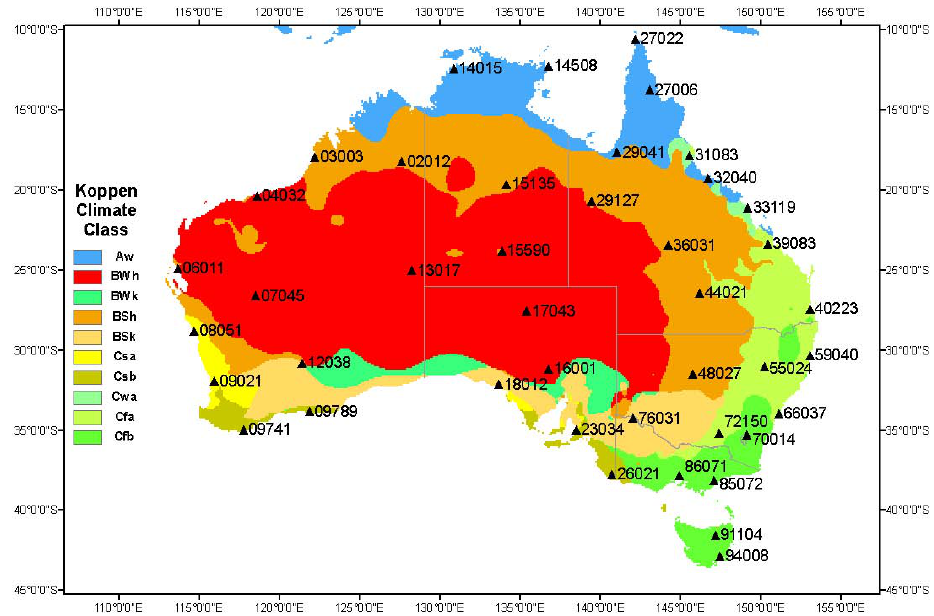
Fig. 1. Map showing the location of the selected 42 pluviograph stations together with the K¨oppen climate zones (Peel et al., 2007) for Aus- tralia. The climate class symbols have the following meanings Aw=tropical, savannah; BWh=arid, dessert, hot; BWk=arid, dessert, cold; BSh=arid, steppe, hot; BSk=arid steppe, cold; Csa=temperate, dry hot summer; Csb=temperate, dry warm summer; Cwa=temperate, dry winter, hot summer; Cfa=temperate, no dry season, hot summer; CFb=temperate, no dry season, warm